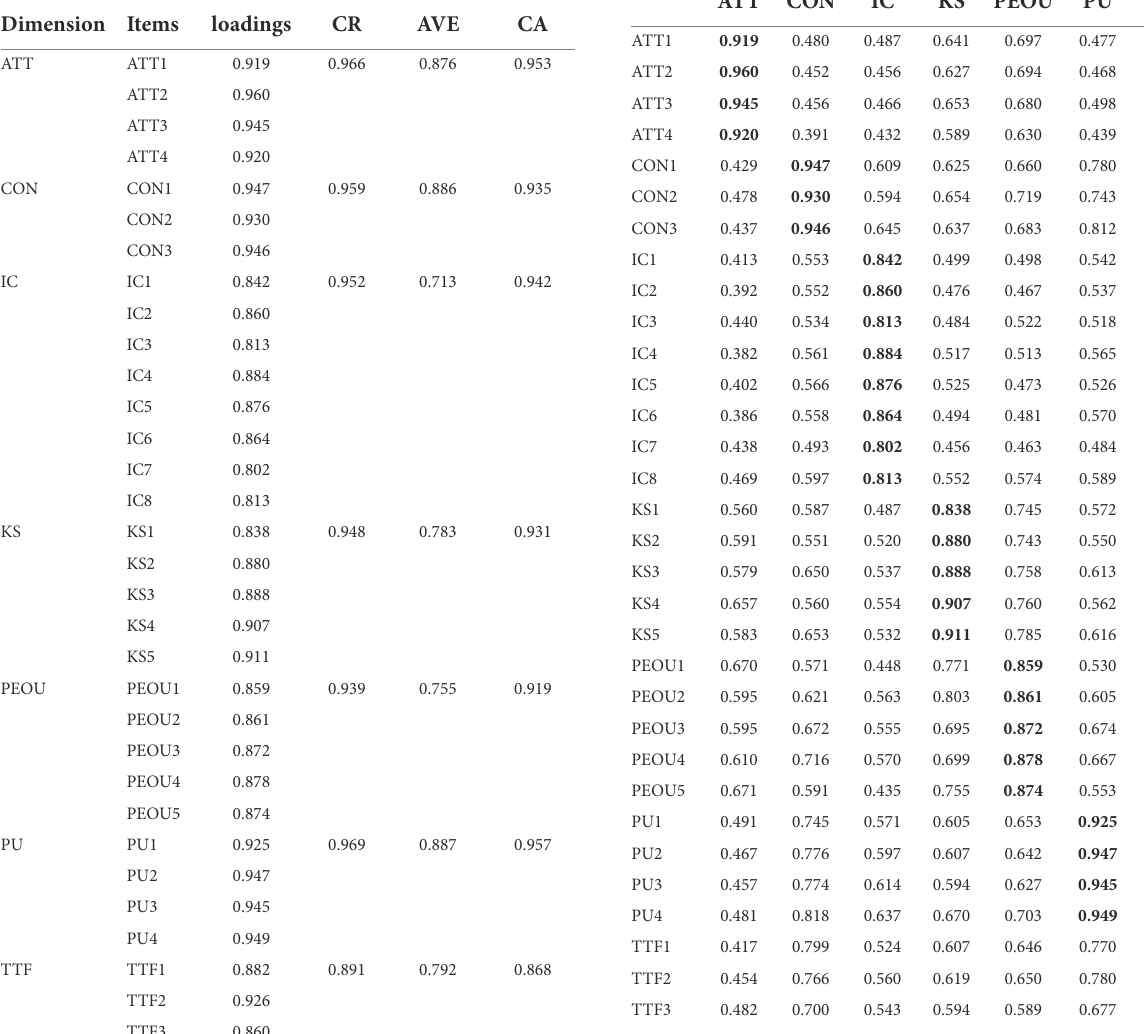
TABLE 5 PLS-loadings and cross-loadings.